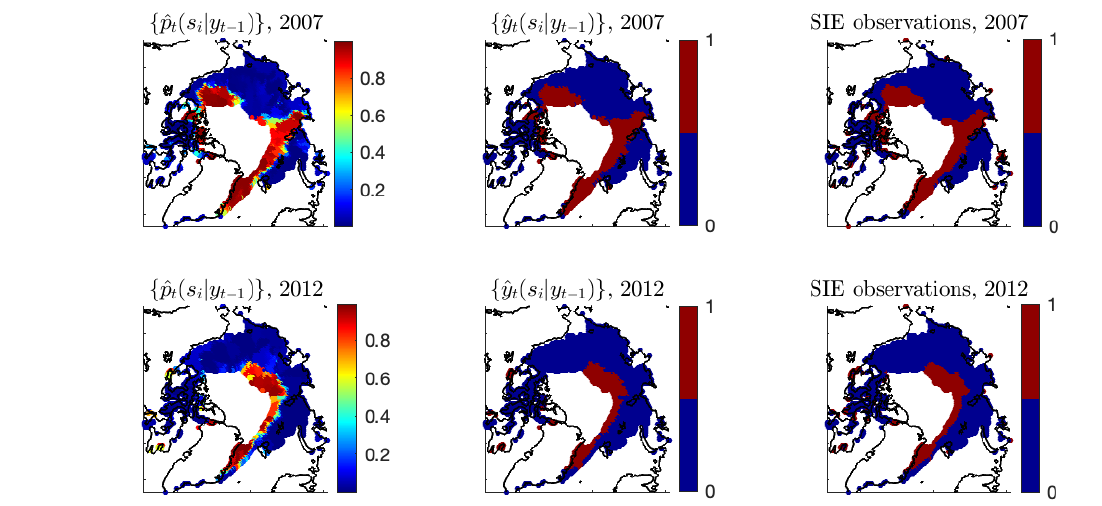
Figure A6. Years 2007 and 2012 are shown. Left panels : The estimates { ˆ p t ( s i | y t − 1 ) } . Middle panels : The estimates { ˆ y t ( s i | y t − 1 ) } using a 0.5 cut-off value to dichotomize { ˆ p t ( s i | y t − 1 ) } . Right panels : The binary Arctic sea ice data derived from satellite